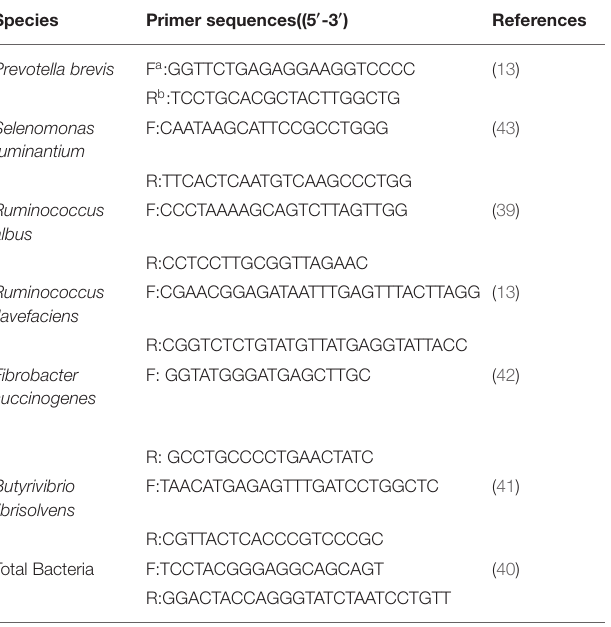
ruminal bacteria. Species